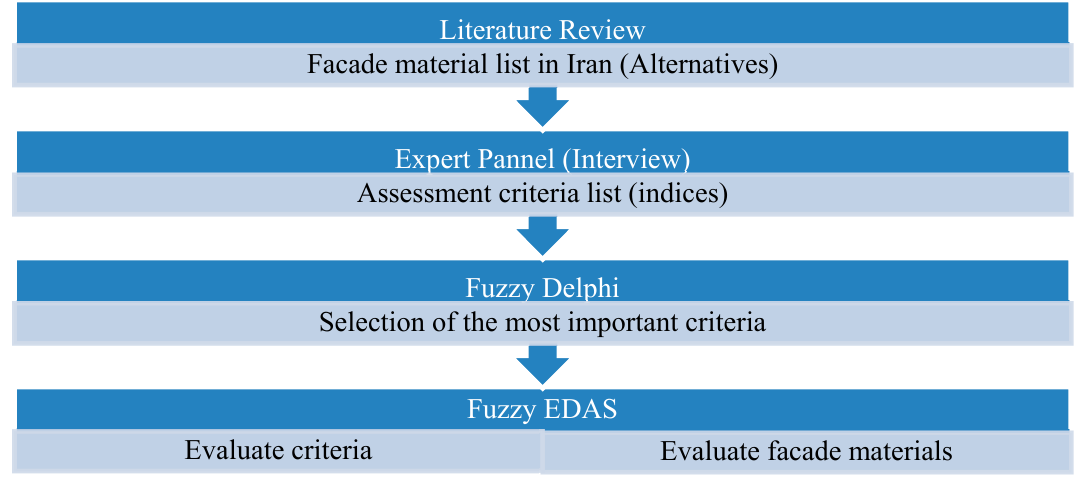
Figure 1. The process of the research.